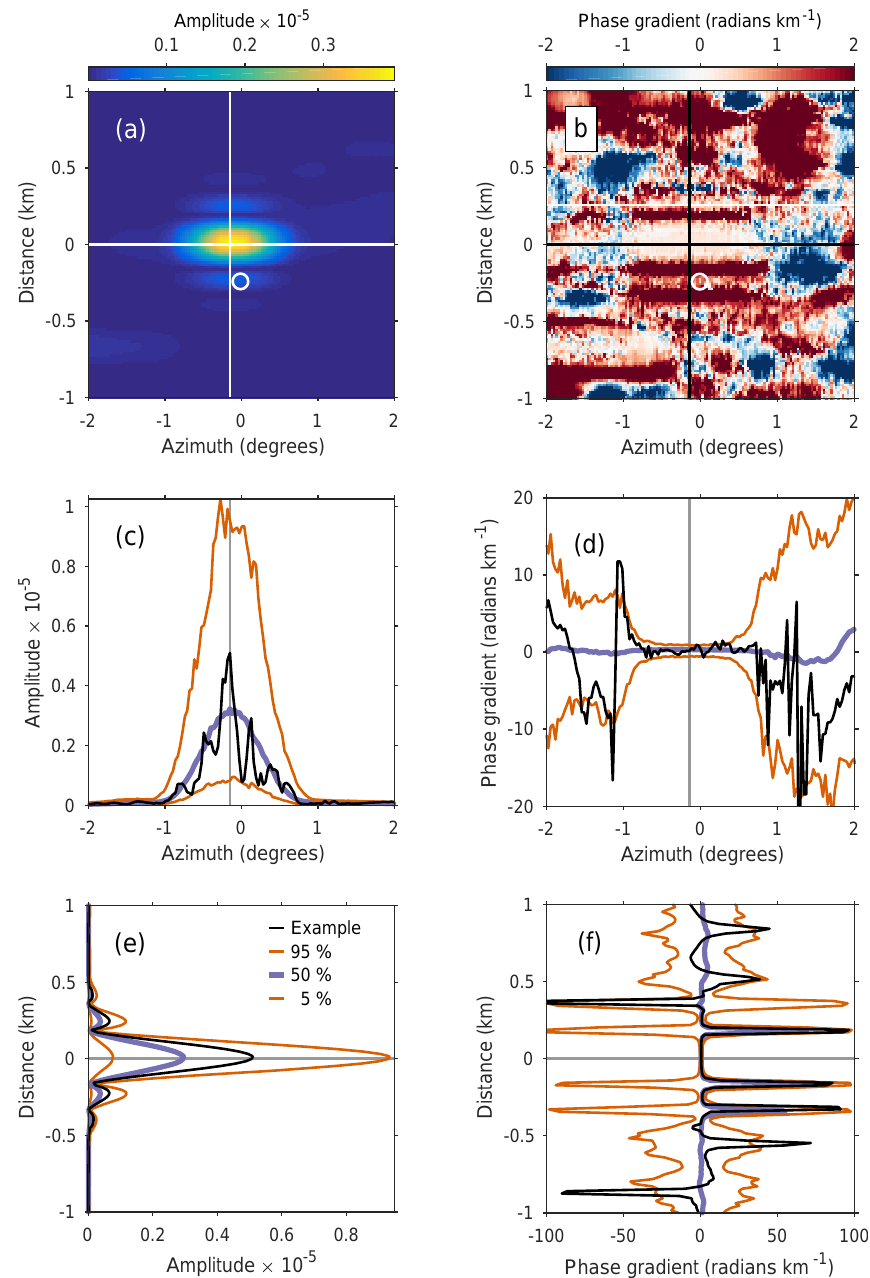
Figure 3. Impact of a wind turbine on weather radar I/Q data, recorded by Vara during September 2016. Panel (a) shows the average I/Q amplitude near the position of the wind turbine, while panel (b) shows the average phase gradient. The position of the wind turbine is marked by a white circle. Black and white vertical and horizontal lines indicate from where data in panels (c) to (f) originate. Panels (c) and (d) show the 5th, 50th and 95th percentiles of the amplitude and phase gradient, respectively, as functions of azimuth. Panels (e) and (f) show the 5th, 50th and 95th percentiles of the amplitude and phase gradient, respectively, as functions of distance. Black lines in panels (c) to (f) show example data from a single